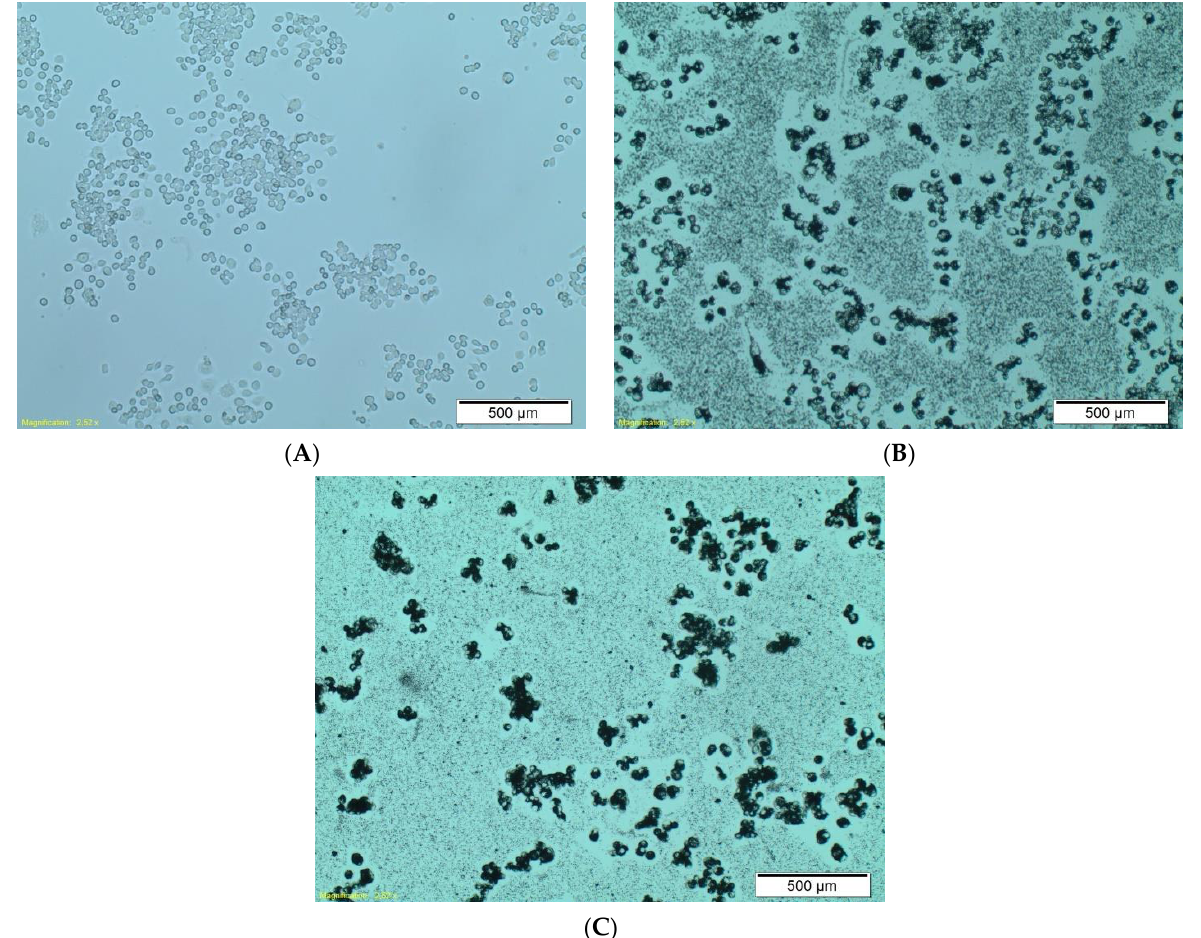
Figure 5. The interaction of RAW264.7 phagocytic cells with boron carbide nanoparticles functionalized by coating with human IgG ( C ). Untreated control cells ( A ) and boron carbide nanoparticles without coating IgG ( B ) after 24 h incubation. We used an Olympus CKX41 light microscope, magnification 6.3 × .